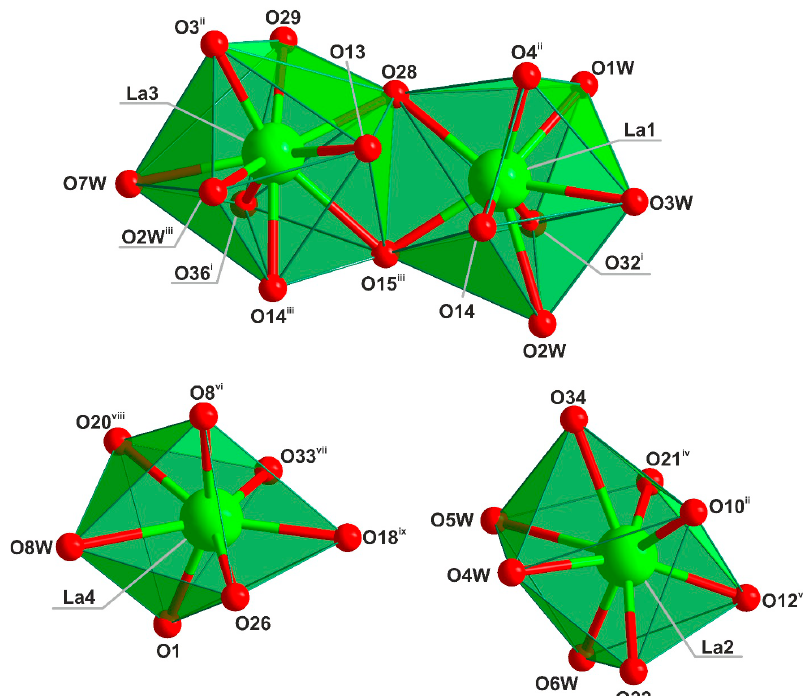
Figure 4. Polyhedral representation of the distorted coordination environments present in the crystal structure of [La 4 (H 5 btp)(H 4 btp)(H 3 btp)(H 2 O) 8 ] ∙ 3H 2 O ( 2La ). See Table S1 for geometrical details on the represented bond lengths and angles. Symmetry transformation used to generate equivalent atoms: (i) − x + 1, y − 1/2, − z + 3/2; (ii) x + 1, y, z; (iii) − x + 1, − y, − z + 1; (iv) − x + 1, − y + 1, − z + 1; (v) − x, − y + 1, − z + 1; (vi) x + 1, − y + 1/2, z + 1/2; (vii) x − 1, y, z; (viii) x − 1, − y + 1/2, z + 1/2; (ix) x, − y + 1/2, z + 1/2.